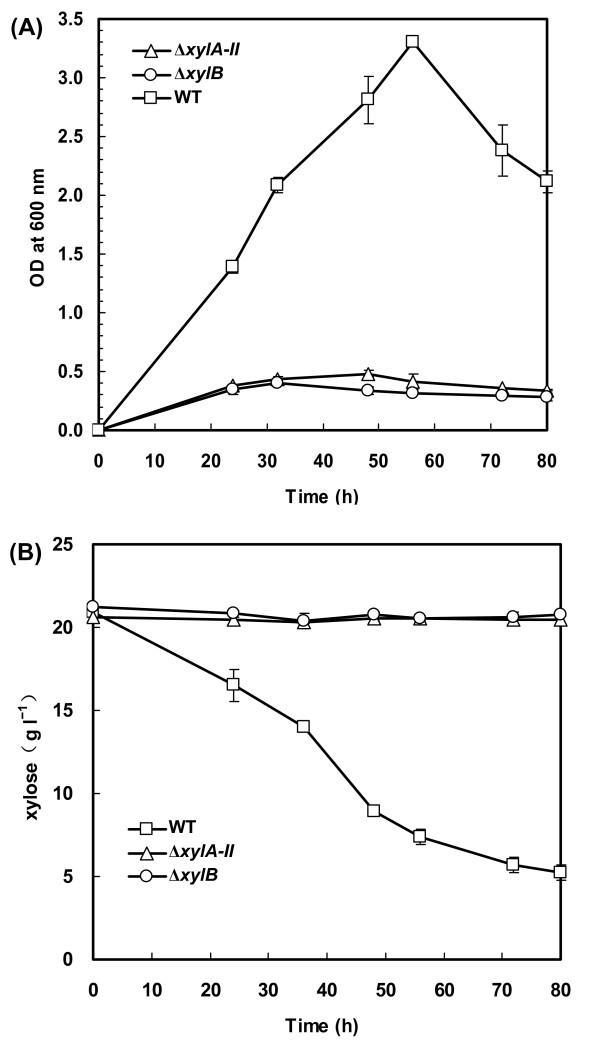
Effect of xylA-II or xylB disruption on cell growth and xylose utilization of C. acetobutylicum. Cells were grown in the medium containing 20 g l-1 of D-xylose as the sole carbon source. The optical density at 600 nm (A) and xylose concentration in the medium (B) were monitored. Data shown are means ± standard deviations calculated from triplicate individual experiments.